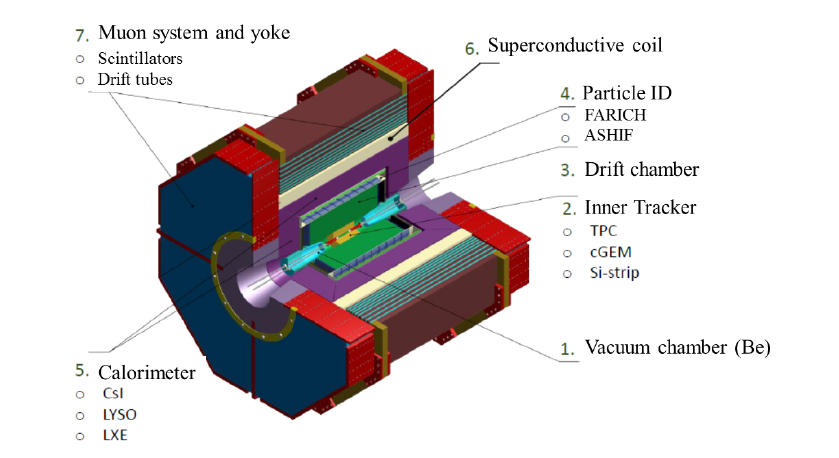
Figure 1. Conceptual design of the Super C- τ factory